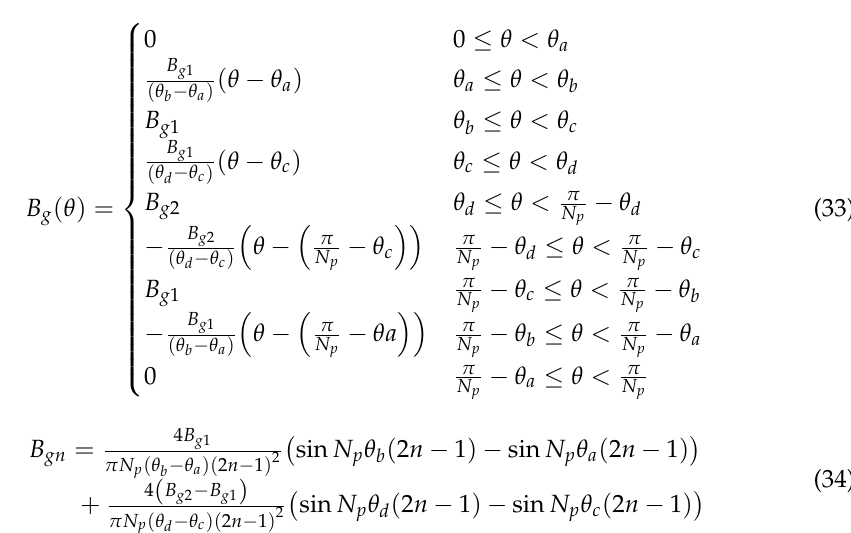
12 of 20 Figure 12. Magnetic equivalent circuit of a V-type rotor. Table 1. Comparison of magnetic field distribution parameters of bar-type and V-type rotor when there is a slot . Type